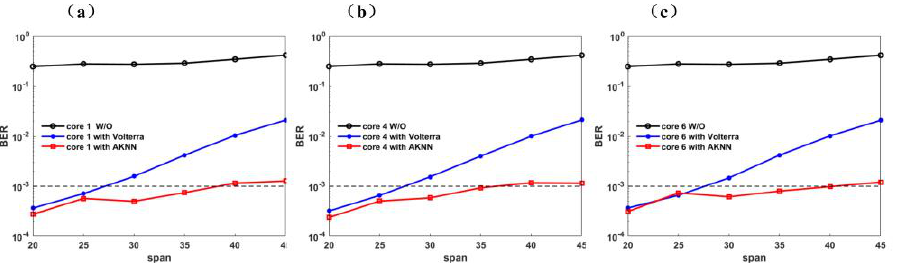
Fig. 6. (a) Relationship between BER and spans of core 1 equalized by AKNN algorithm; (b) Relationship between BER and spans of core 4 equalized by AKNN algorithm; (c) Relationship between BER and spans of core 6 equalized by AKNN